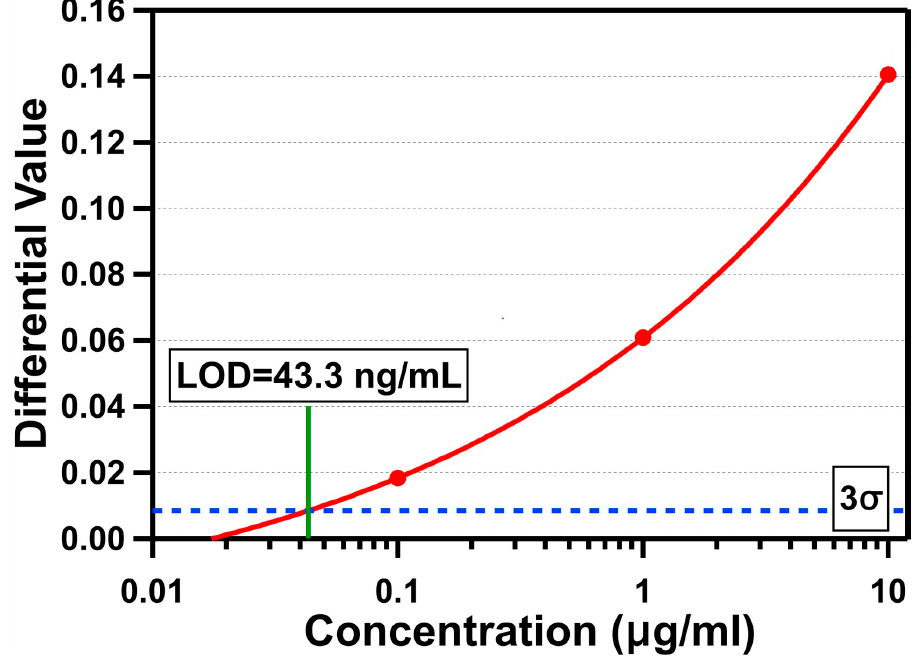
Figure 7. Differential values versus three concentrations of C-reactive protein (CRP) in a log scale.